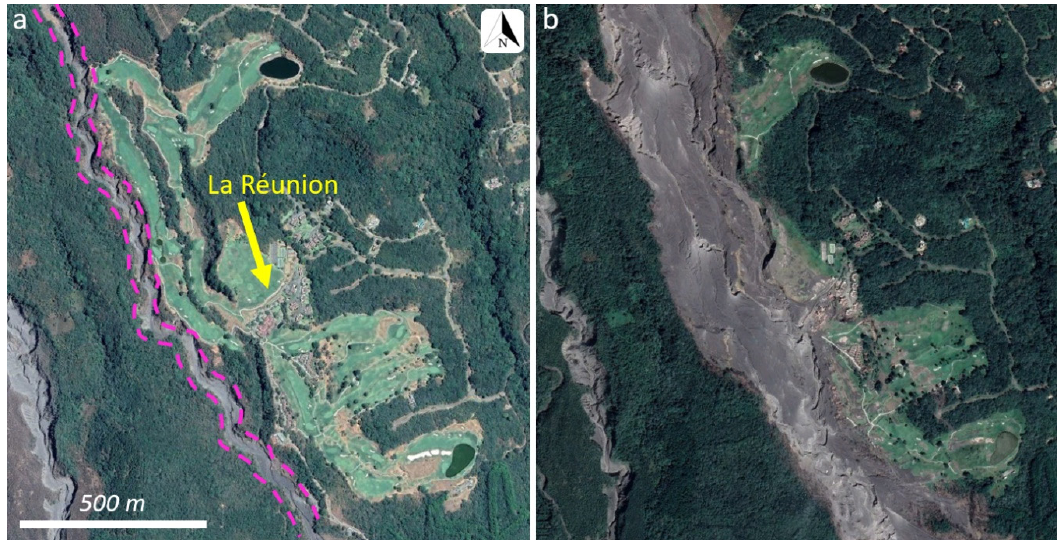
Figure 2. Satellite images of the La Réunion golf resort. Las Lajas barranca (outlined) lies directly to the west of the resort and golf course. ( a ) 7 March 2018 (prior to the eruption). ( b ) 14 November 2018 (~5 months after the eruption). Images from Google Earth.